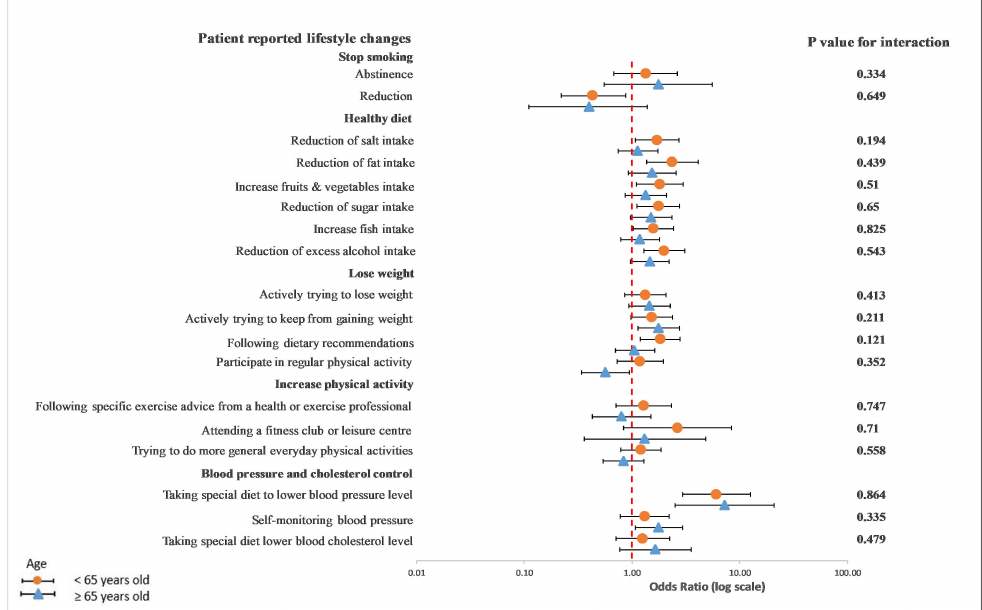
Figure 4. Multivariable logistics regression analysis between the recollection of risk factors and patients’ reported lifestyle changes. The p -value corresponds to the interaction between younger and older patients. The model included the recollection of risk factor information (PRRFI = 0 and GRRFI = 1) as the independent variable, patients’ reported lifestyle changes (no = 0 and yes = 1) as the dependent variables, and gender, the index event, and obesity, as well as diabetes at hospitalization, as covariates. PRRFI: poor recollection of risk factor information; GRRFI: good recollection of risk factor information.